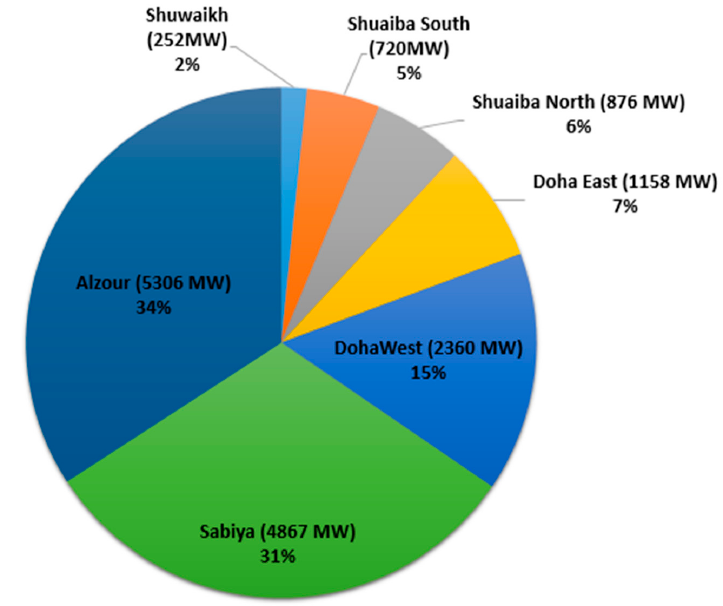
Figure 1. Power generation from the combustion of fossil fuel [7].